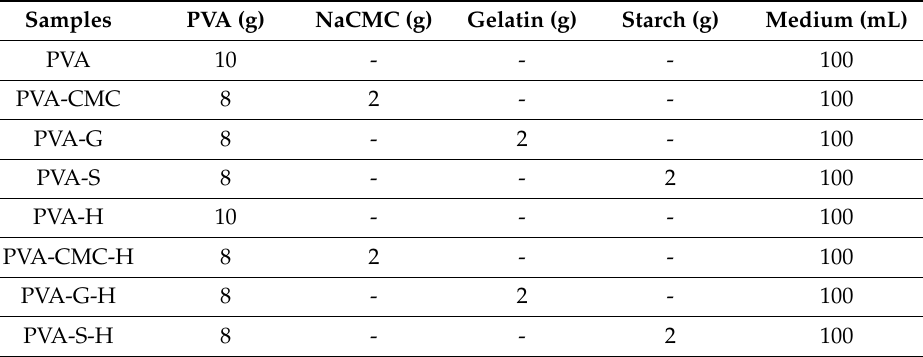
Table 2. Composition of samples according to polymer